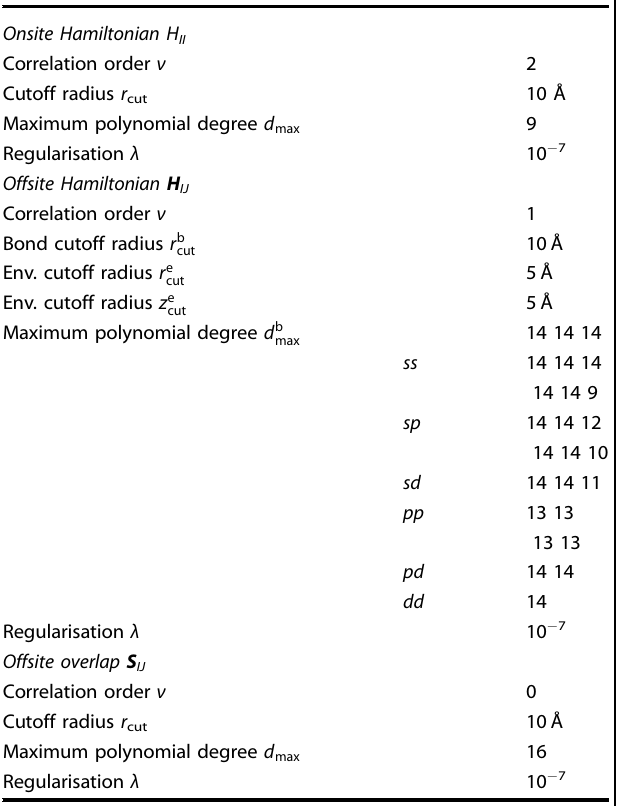
Table 1. ACE basis set parameters for our optimised models for H II , H IJ and S